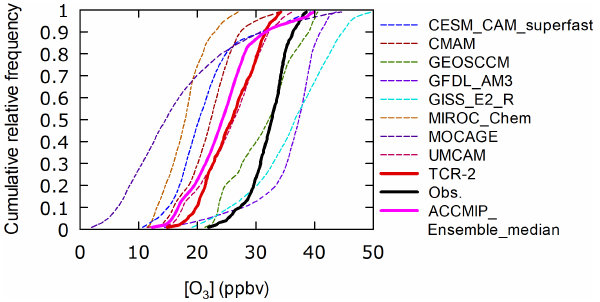
Figure 10. Cumulative relative frequency distributions of O 3 mix- ing ratios from observations (black), TCR-2 (red), and members and ensemble median of ACCMIP in the Arctic grid 1 (72.5–77.5 ◦ N, 190–205 ◦ E) in